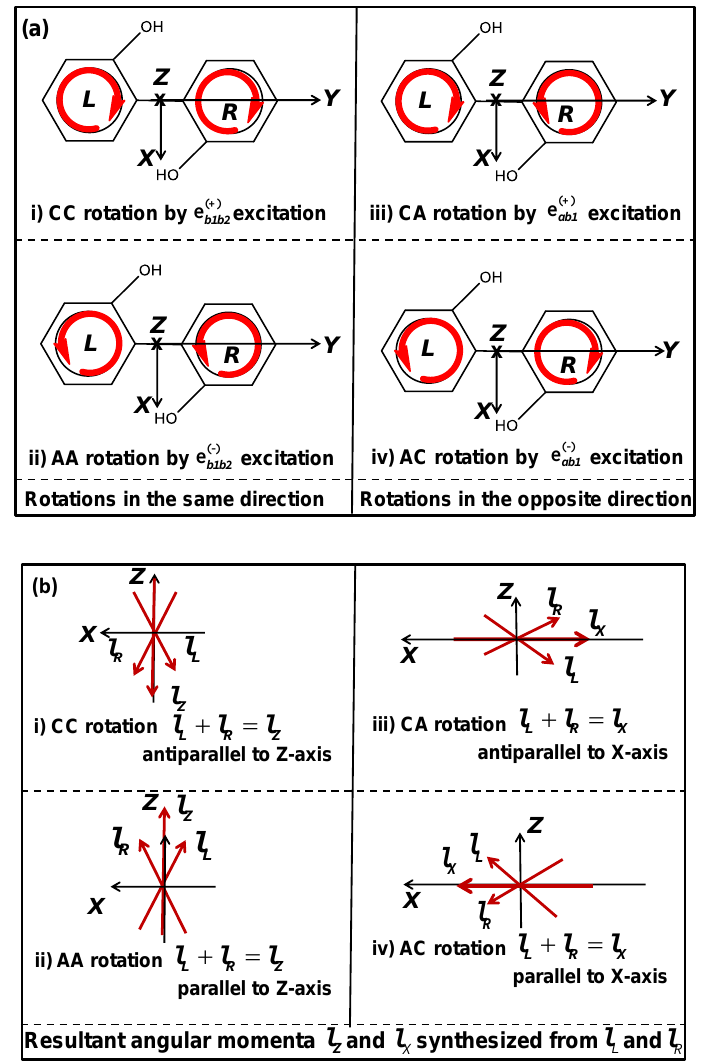
Figure 12. ( a ) Four patterns of π -electron rotations induced by selective coherent electronic excitations. For example, CA rotation means clockwise and anticlockwise rotations along the phenol rings L and R , respectively. ( b ) Resultant angular momenta l Z and l X for the four rotational patterns. l L ( l R ) denotes the electronic angular momentum of the L ( R ) ring. Modified from [86] with permission of the American Chemical Society.